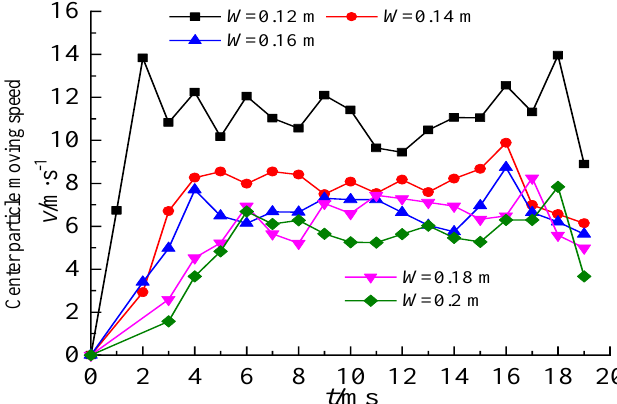
Figure 12. Time history curve of the velocity of the center particle.